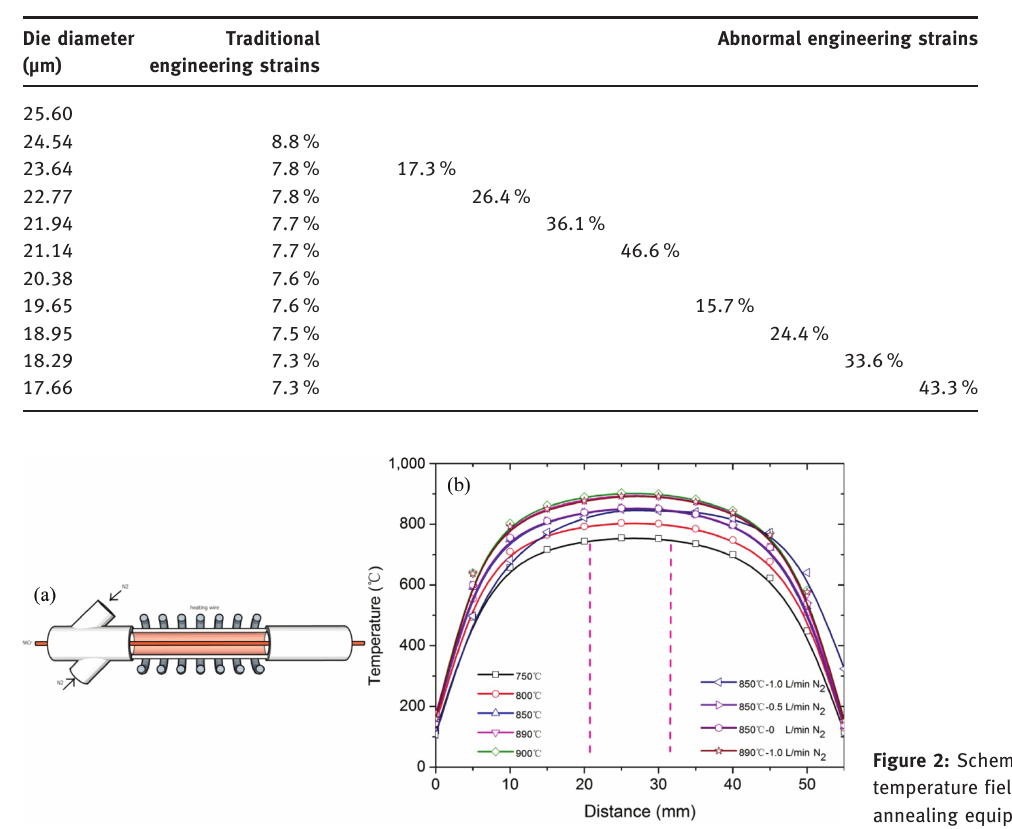
Figure 2: Schematic diagram and temperature field distribution of annealing equipment.